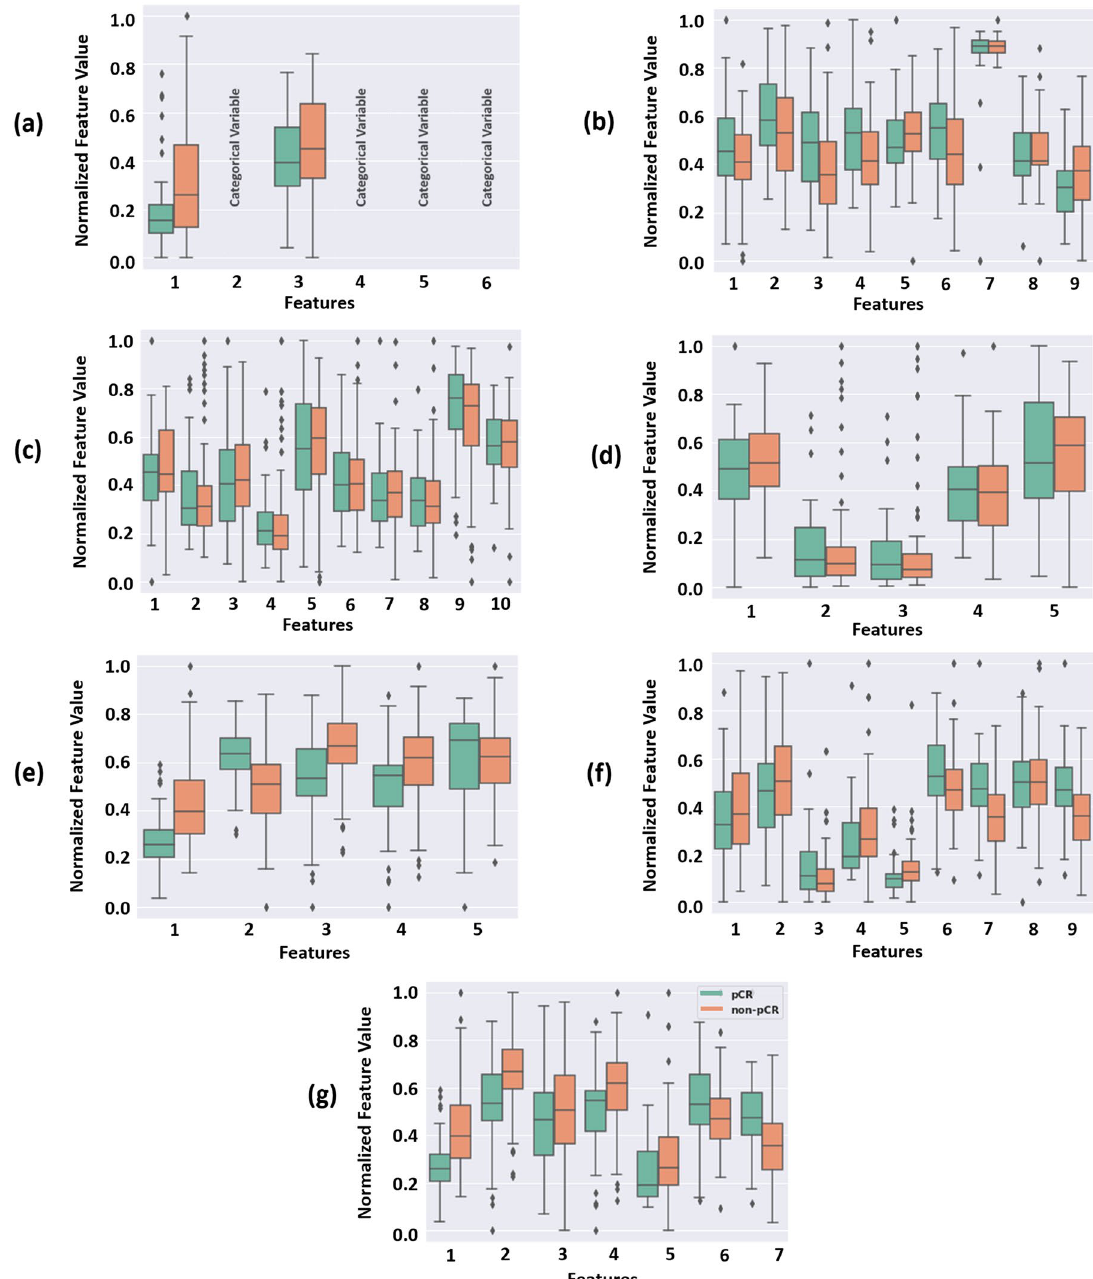
Figure 3. Box plots of the selected features for the pCR and non-pCR cohorts of the training set obtained in the seven experiments conducted using different feature subsets: ( a ) clinical, ( b ) morphological, ( c ) intensity-based, ( d ) texture, ( e ) graph-based, ( f ) wavelet, and ( g ) all features. The feature values are normalized in the range of 0 and 1. The order of features in each plot is the same as that of the associated plot in Fig.